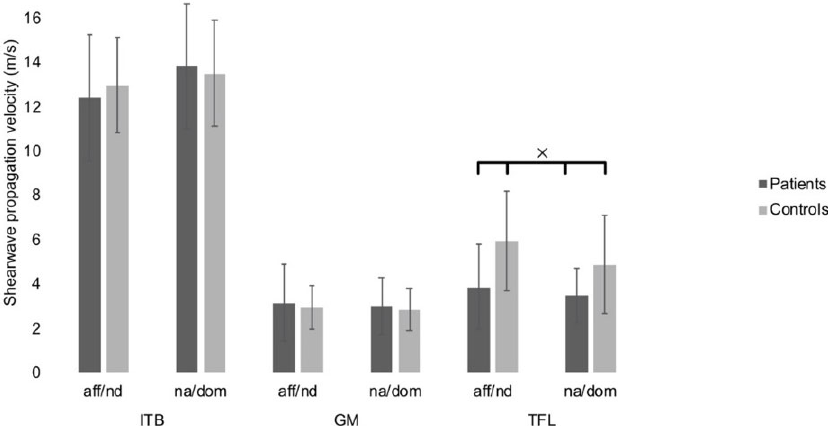
Figure 4. Baseline data of shear wave propagation velocity. Bars and error bars represent the means and standard deviations measured in the iliotibial band (ITB), gluteus maximus (GM) and tensor fasciae latae (TFL) muscles. Results are separately shown for the affected or non-dominant (aff/nd) and non-affected or dominant (na/dom) limbs, respectively. Note the significant difference between patients and healthy participants in the TFL (between cross).